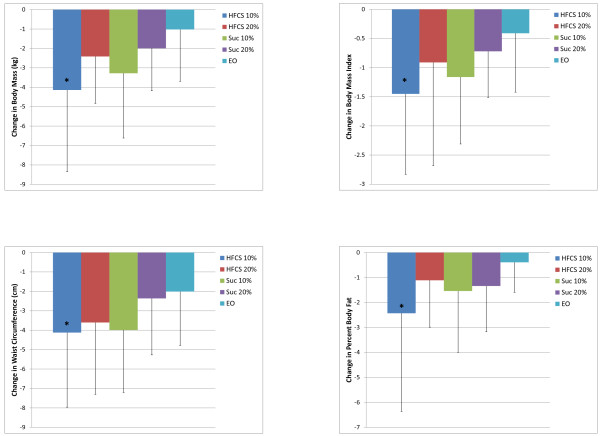
Changes in body mass and measures of adiposity after 12 weeks on a (500Kcal/day) hypercaloric diet containing either 10% or 20% of calories from HFCS.